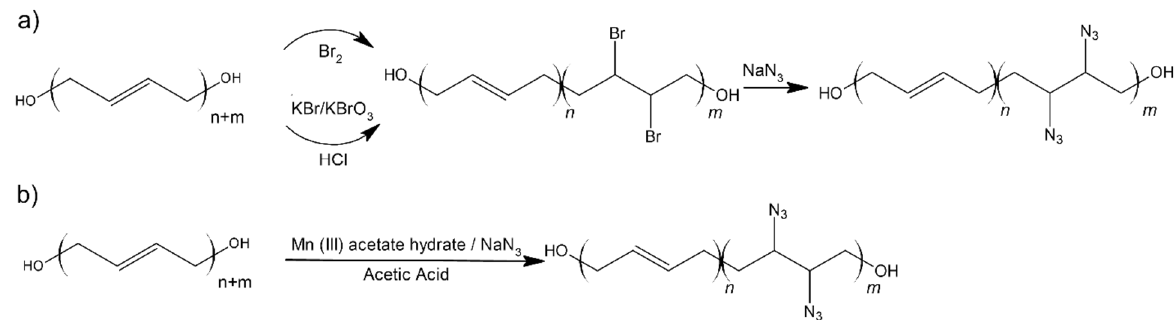
Figure 5. Synthesis of azidated hydroxyl-terminated polybutadiene (HTPB): ( a ) two-step method; ( b ) one-step method.